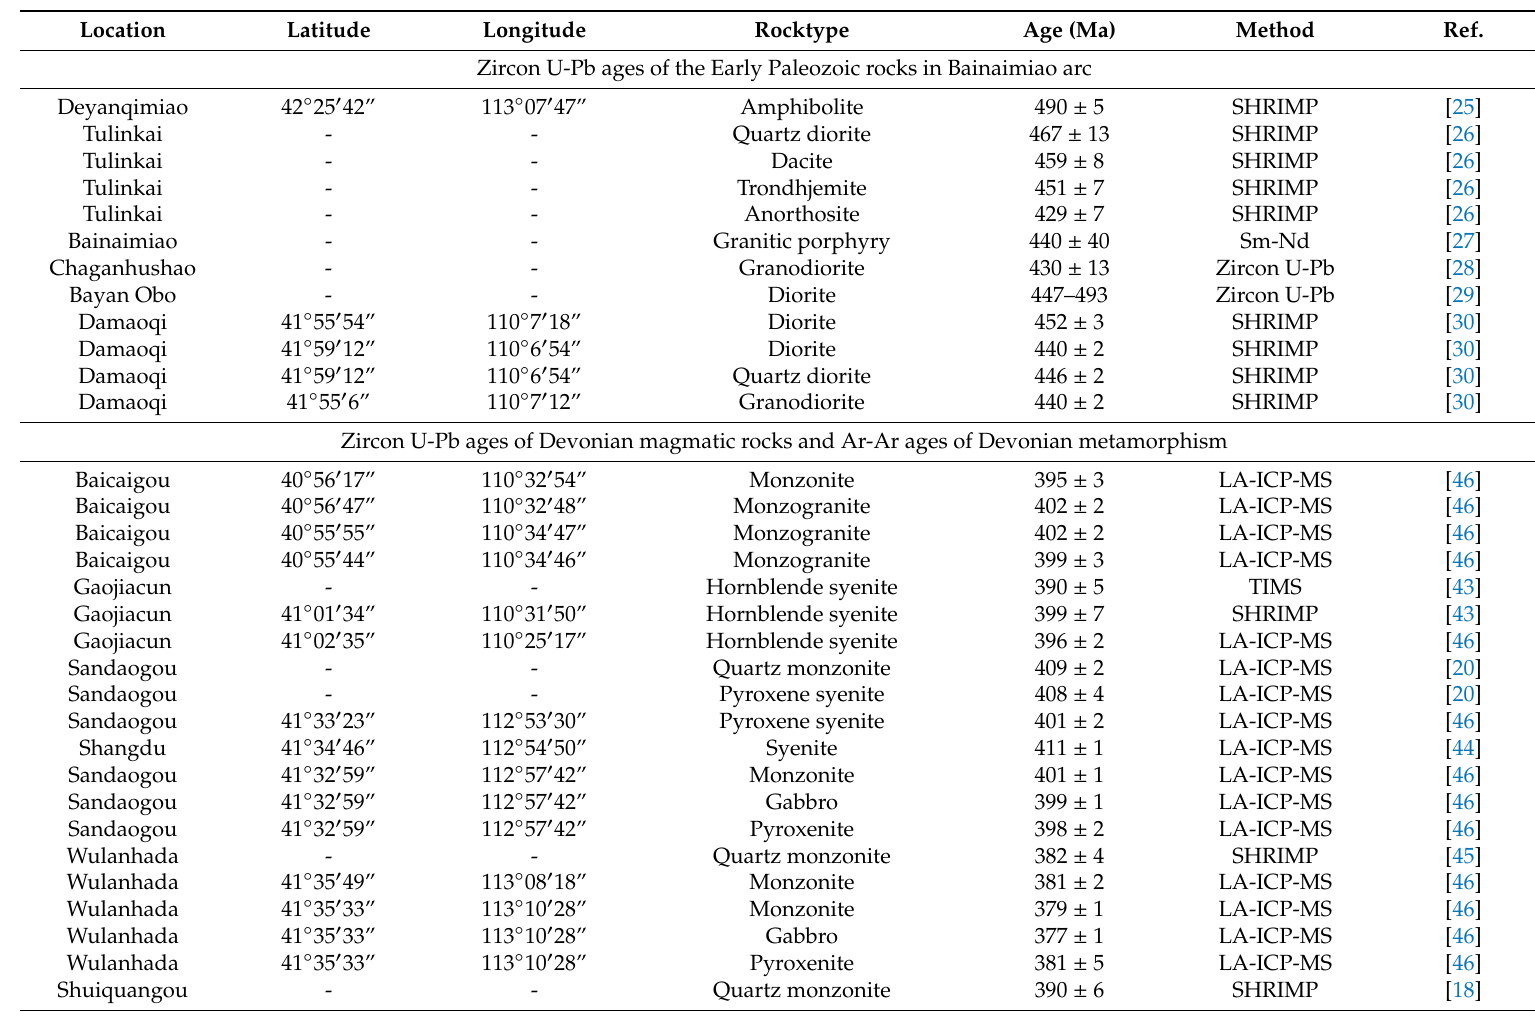
Table 1. Summary of zircon U-Pb ages of the Early Paleozoic rocks in Bainaimiao arc, Early-Late Devonian magmatic rocks, and Ar-Ar ages of Devonian metamorphism from the northern North China Craton